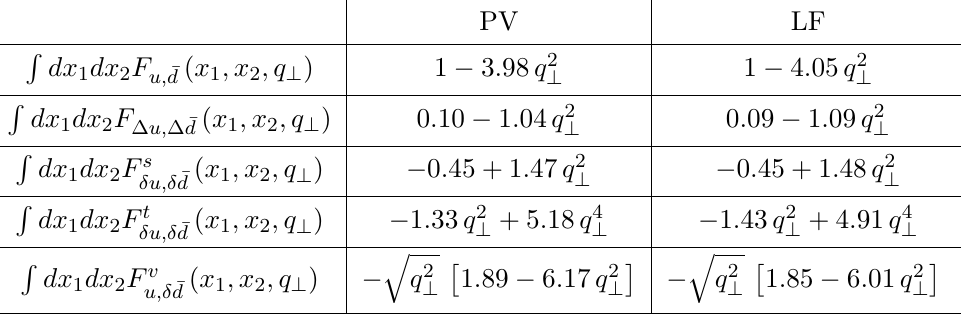
( x 1 ; x 2 ; q ? ), for q ? 1 ; (cid:22) a